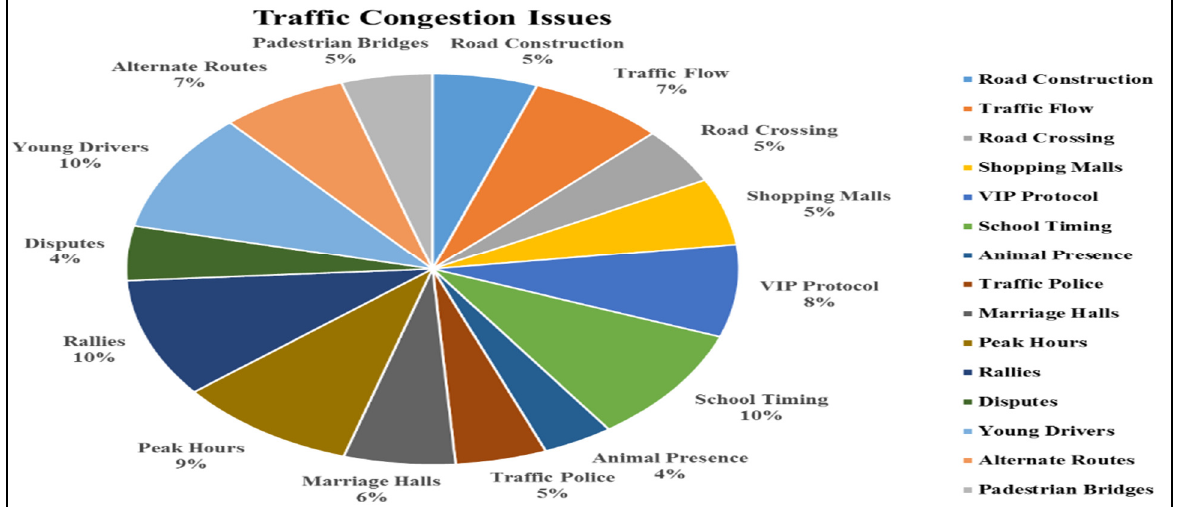
FIG. 4. ISSUES OF TRAFFIC CONGESTION AS IDENTIFIED BY CAR OWNERS AND DRIVERS TABLE 2: THE SERIOUSNESS OF TRAFFIC CONGESTION ISSUES AS IDENTIFIED BY